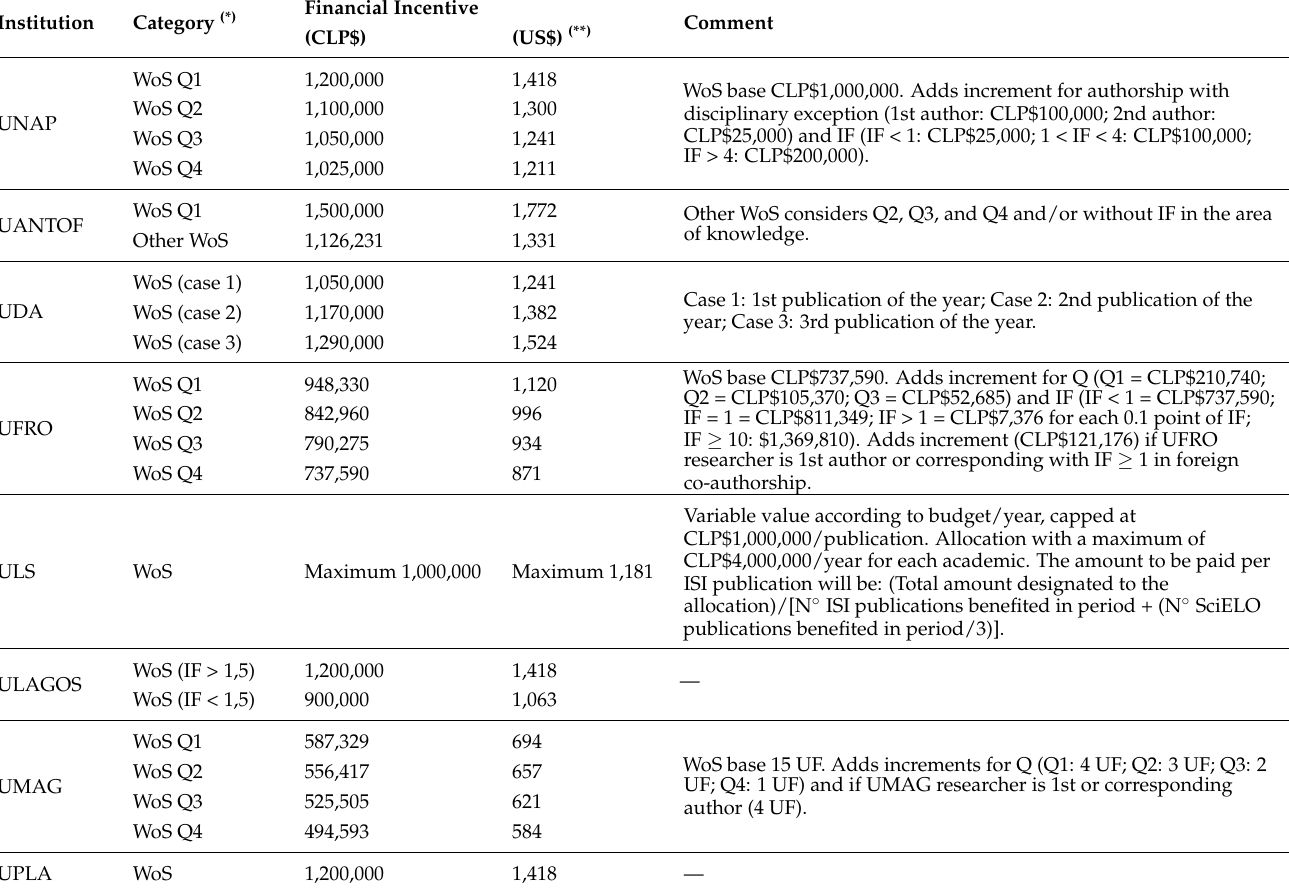
Table 4. Incentive amounts for publications indexed in the Web of Science